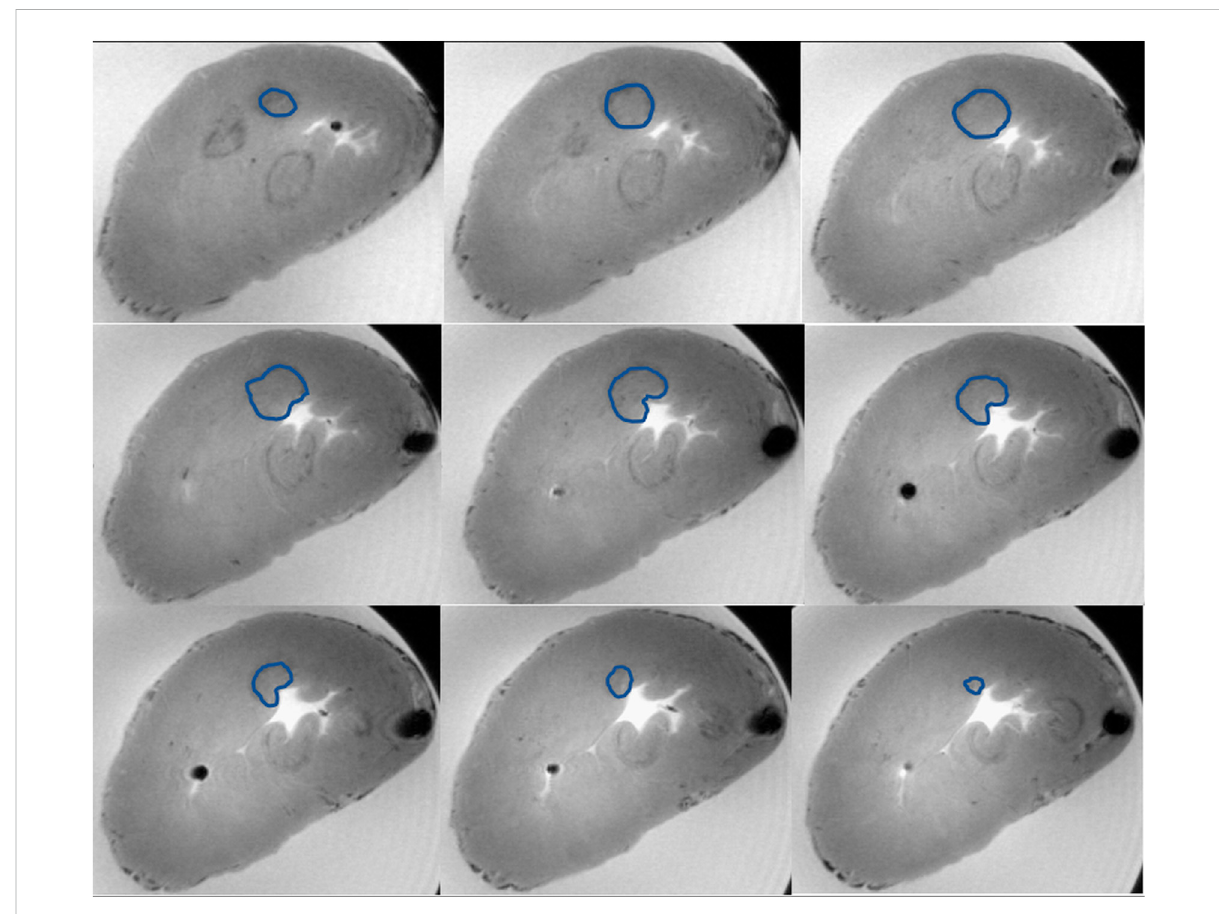
FIGURE 3 Example of volume measurement with the “ point-by-point ” method from MRI data. On the picture you can see nine subsequent transverse sections of the left ventricle capturing the whole radiofrequency lesion. Three lesions are visible, the upper one is measured. The measured lesion is outlined in all scans with a blue line. The resulting volume is the sum of the individual volumes from all involved MRI